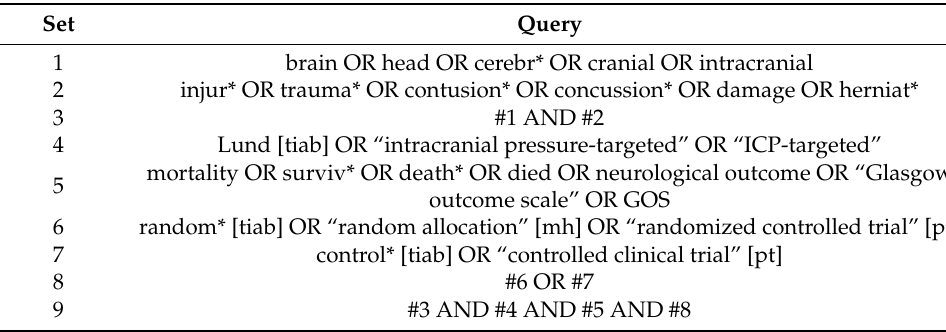
Table 1. Representative the MEDLINE search